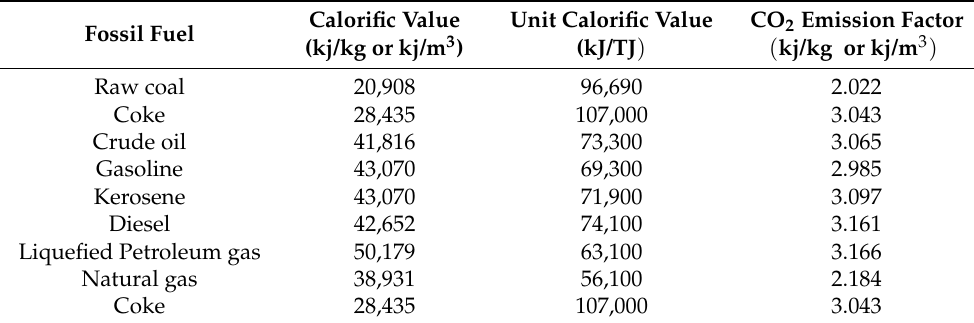
Table 2. Calorific values and CO 2 emission factors of fossil fuel combustion 1 .